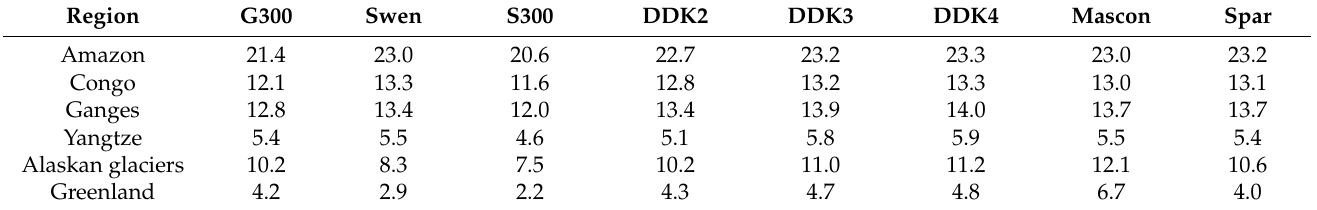
Table 5. The regional average annual amplitude of filtered mass anomaly solutions in six areas of different latitudes. The results are based on data from January 2004 to December 2010 and presented in EWH